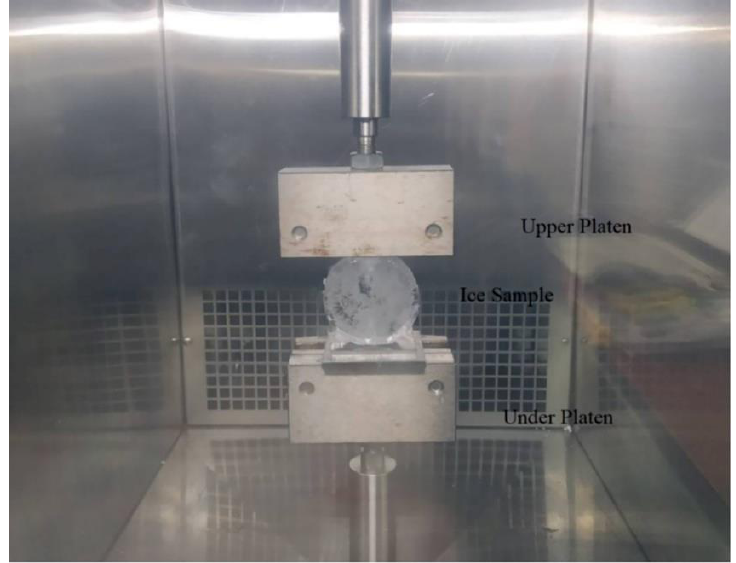
Figure 15. Brazilian disc splitting test device.